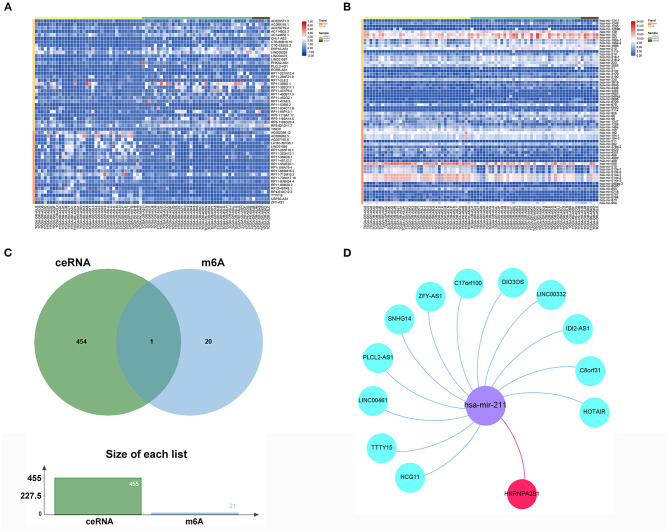
ceRNA network construction of key m6A-related gene. (A) The heatmap of significant differential expression lncRNAs. (B) The heatmap of significant differential expression miRNAs. (C) The Venn plot of 455mRNAs and 21 m6A regulators. (D) The ceRNA network of the 12 m6A-related lncRNAs (blue) and target miRNAs (purple) and mRNAs (red).